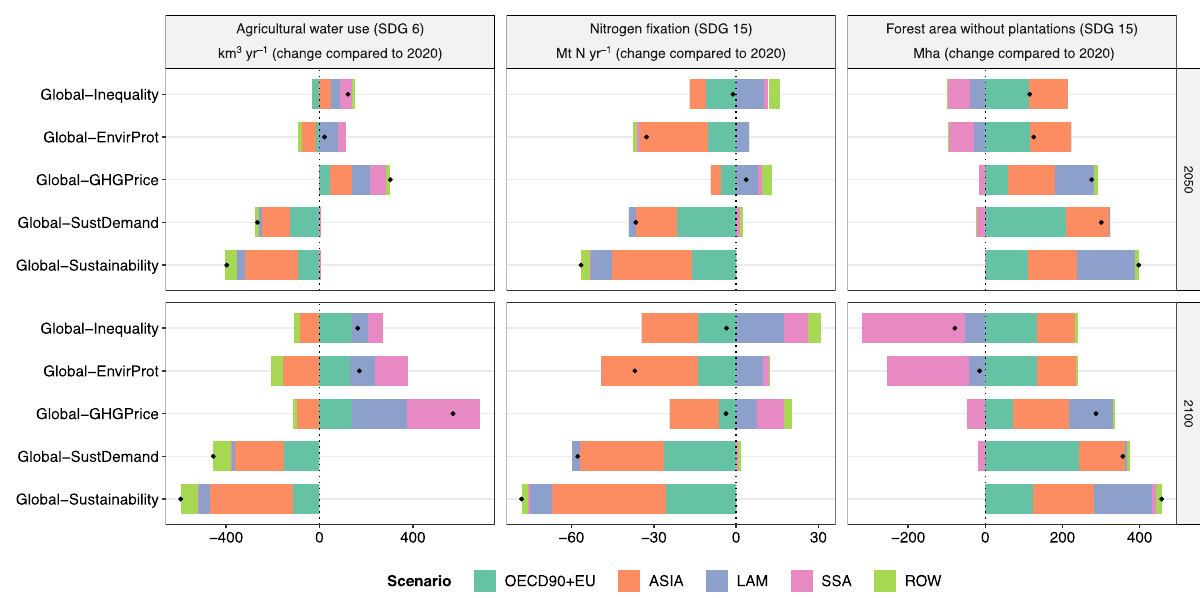
Fig. 8 | Change in agriculturalwater use,nitrogen fi xation, and forest area. Data are shown relative to 2020 for fi ve scenarios at regionallevel forthe years 2050 and 2100. The black dot indicates the net effect at the global